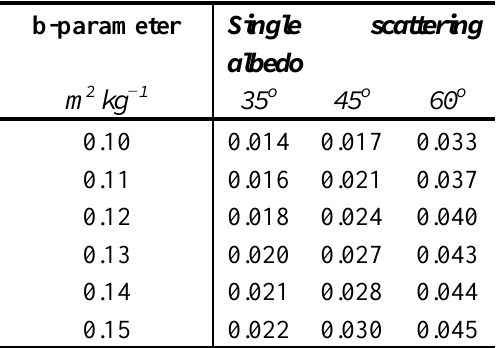
measured on June 9, 2002 B